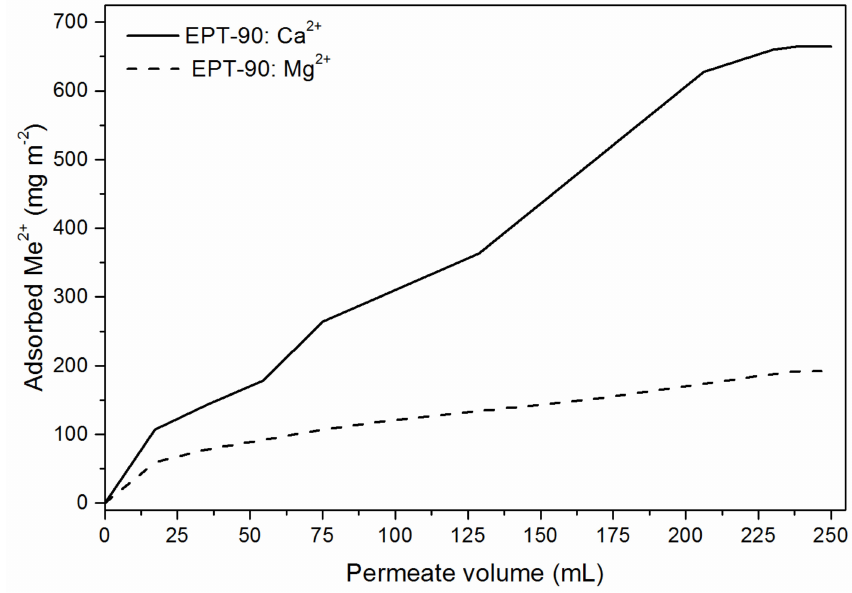
Figure 9. Adsorption of (full line) Ca 2+ and (dashed line) Mg 2+ onto a 90 gsm EPT-CNF nanopaper per unit membrane area vs. permeate